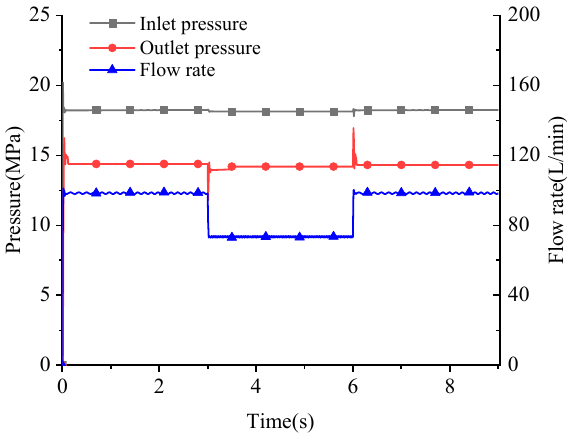
Figure 17. Pressure varies curve with flow change.